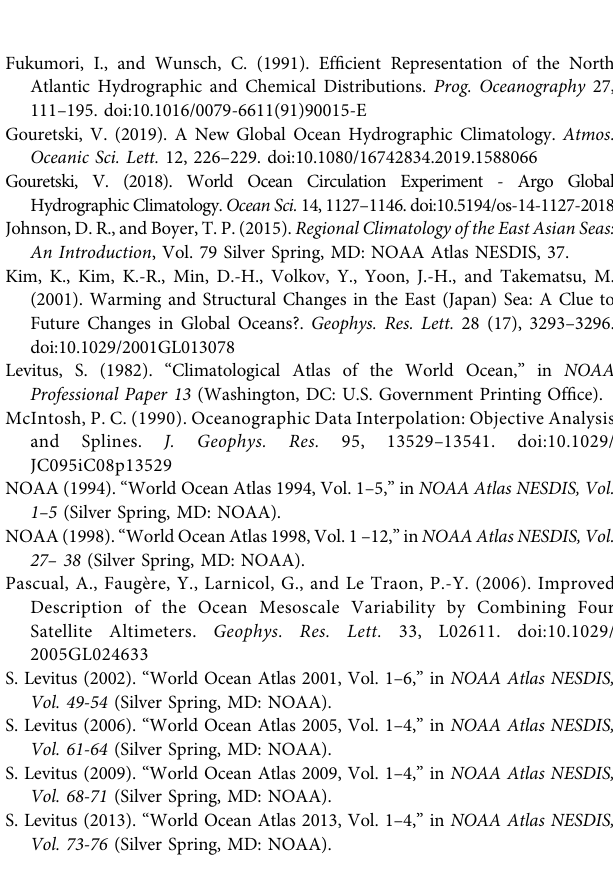
Supplementary Figure 1 | Spatial distribution of temperature and the bias with respect to serial observation at 100 m depth in February. [ (A) Observation, (B) EASRC, (C) new OI, (D) EASRC-OBS, (E) new OI-OBS]. Supplementary Figure 2 | The same as Supplementary Figure S1 except serial observation is at 10 m depth for August. Supplementary Figure 3 | The same as Supplementary Figure S1 except serial observation is at 100 m depth for